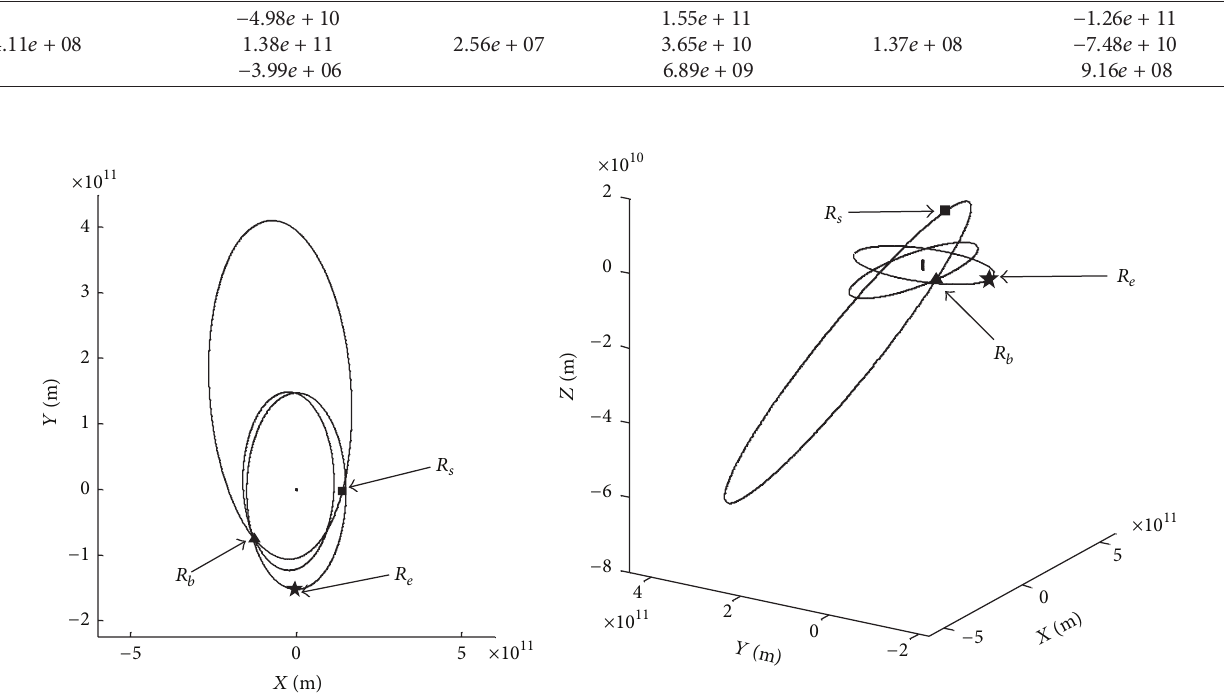
Figure 4: Ends of vectors 𝑅 𝑒 , 𝑅 𝑠 , and 𝑅 𝑏